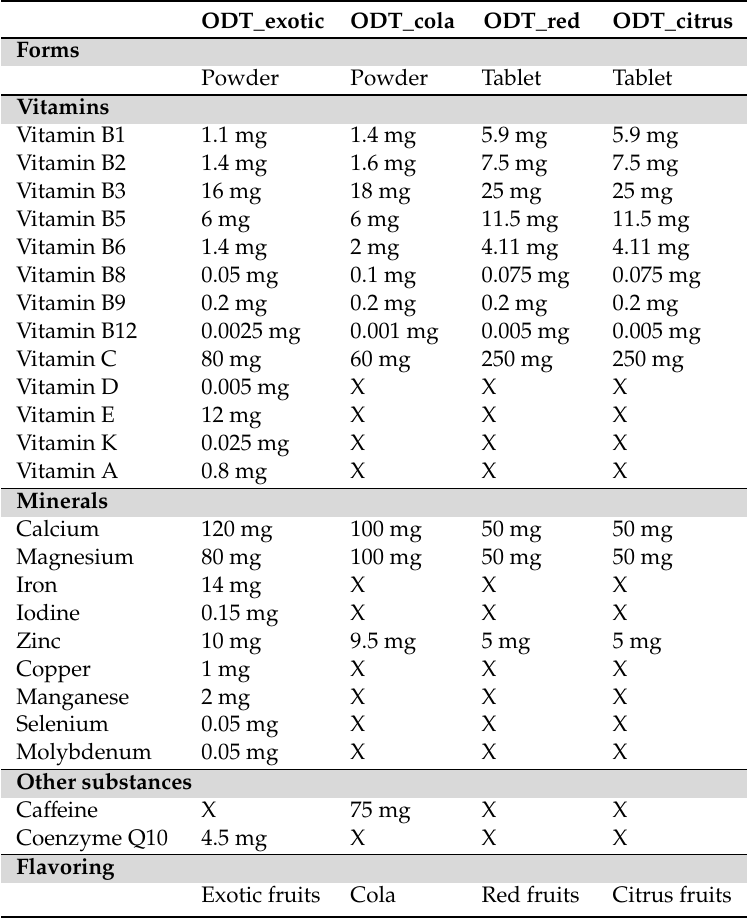
Table 1. Form, composition and flavoring of the four-orodispersible nutritional supplements